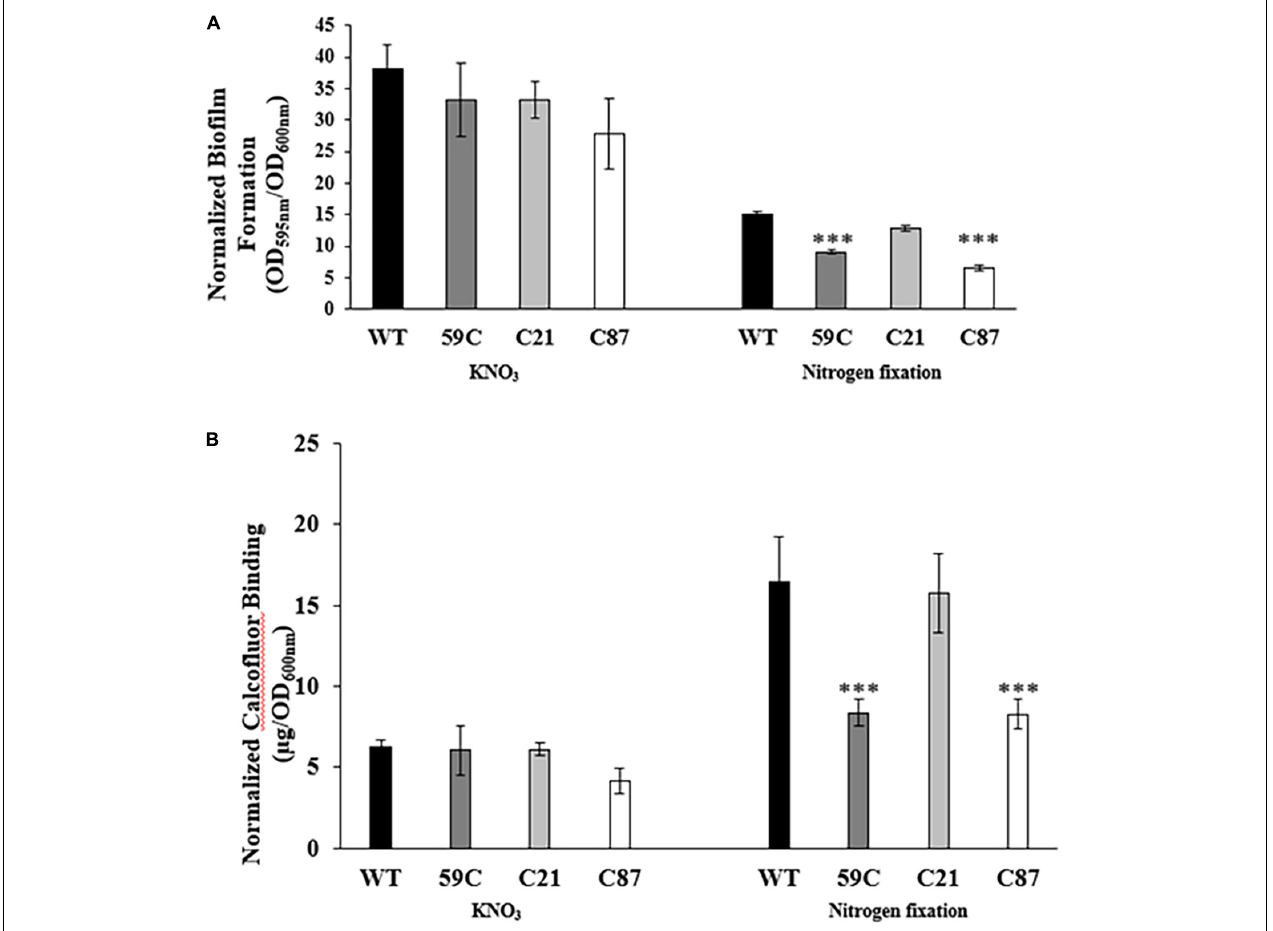
FIGURE 3 | Biofilm formation and exopolysaccharide production assays. (A) Bar plots representing the mean and standard deviation of biofilm quantification assays of Azospirillum strains ( A. baldaniorum WT, A. baldaniorum 59C mutant, A. baldaniorum C21 mutant complemented with cdgC gene, A. baldaniorum C87 mutant without cdgC gene) grown in NFB* media supplemented with KNO 3 or NFB media. (B) Bar plots representing the mean and standard deviation of calcofluor-binding assays from same above Azospirillum strains grown in NFB* media supplemented with KNO 3 or NFB media. The data shown were obtained from three independent experiments. The means of the wild-type strain and the mutant strain were compared using a Student’s t -test. Asterisks indicate a P- value = 0.00042 in (A) and P -value = 0.00868 in (B)